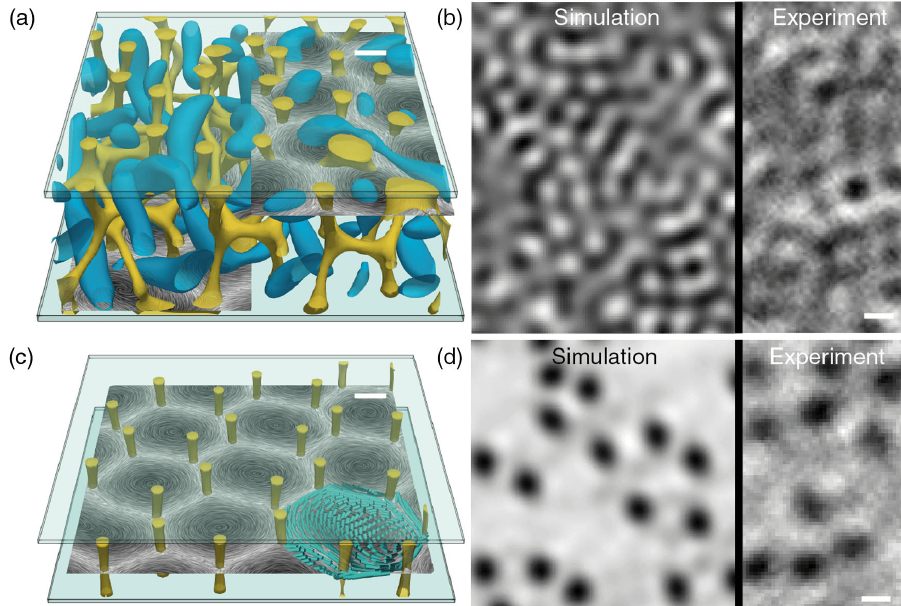
FIG. 9. Numerical and optical simulations of thin layers of BPIII. (a) Skyrmion filaments (light blue) and − 1 = 2 defect lines (yellow) in 300-nm-thick LC with strong surface anchoring. The intertwined lattices of skyrmion filaments and defects start filling the space, forming the BPIII. (b) Optical simulation of light reflected from the structure in (a) and comparison with the experimental image of BPIII at an experimental cell of approximately 300 nm thickness. (c) Simulated baby half-skyrmions in 135-nm-thin layer of BPIII are vortexlike formations of the director, filling the space between − 1 = 2 disclination lines connecting the upper and lower surfaces. (d) Optical simulation of numerically calculated half-skyrmions below the crossover thickness (135 nm) and comparison with experiments. The color scale of the director in (a) and (c) is from zero (white) to one (black) and denotes the out-of-plane director component. Scale bars indicate 100 nm on (a) and (c) and 50 nm in (b) and